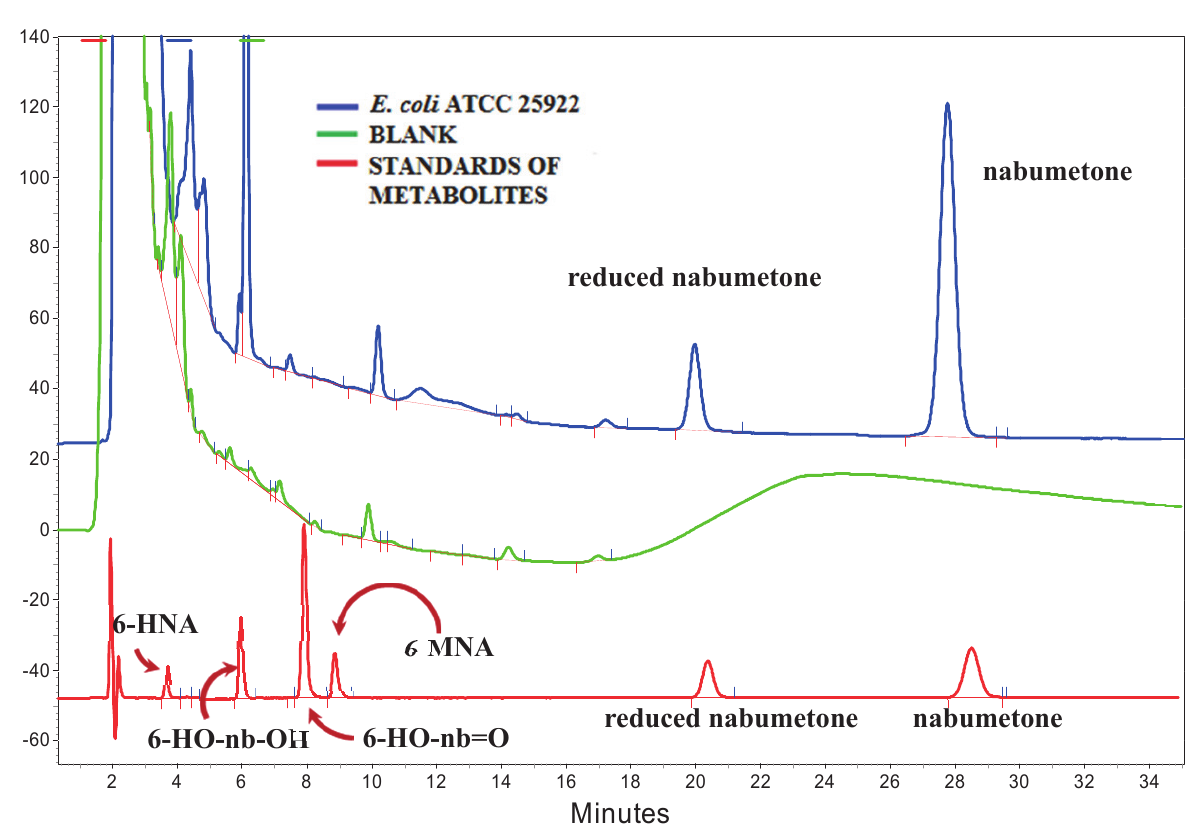
Fig. 4. chromatographic separation of nabumetone and its metabolites after incubation with the commensal bacteria E. coli aTcc